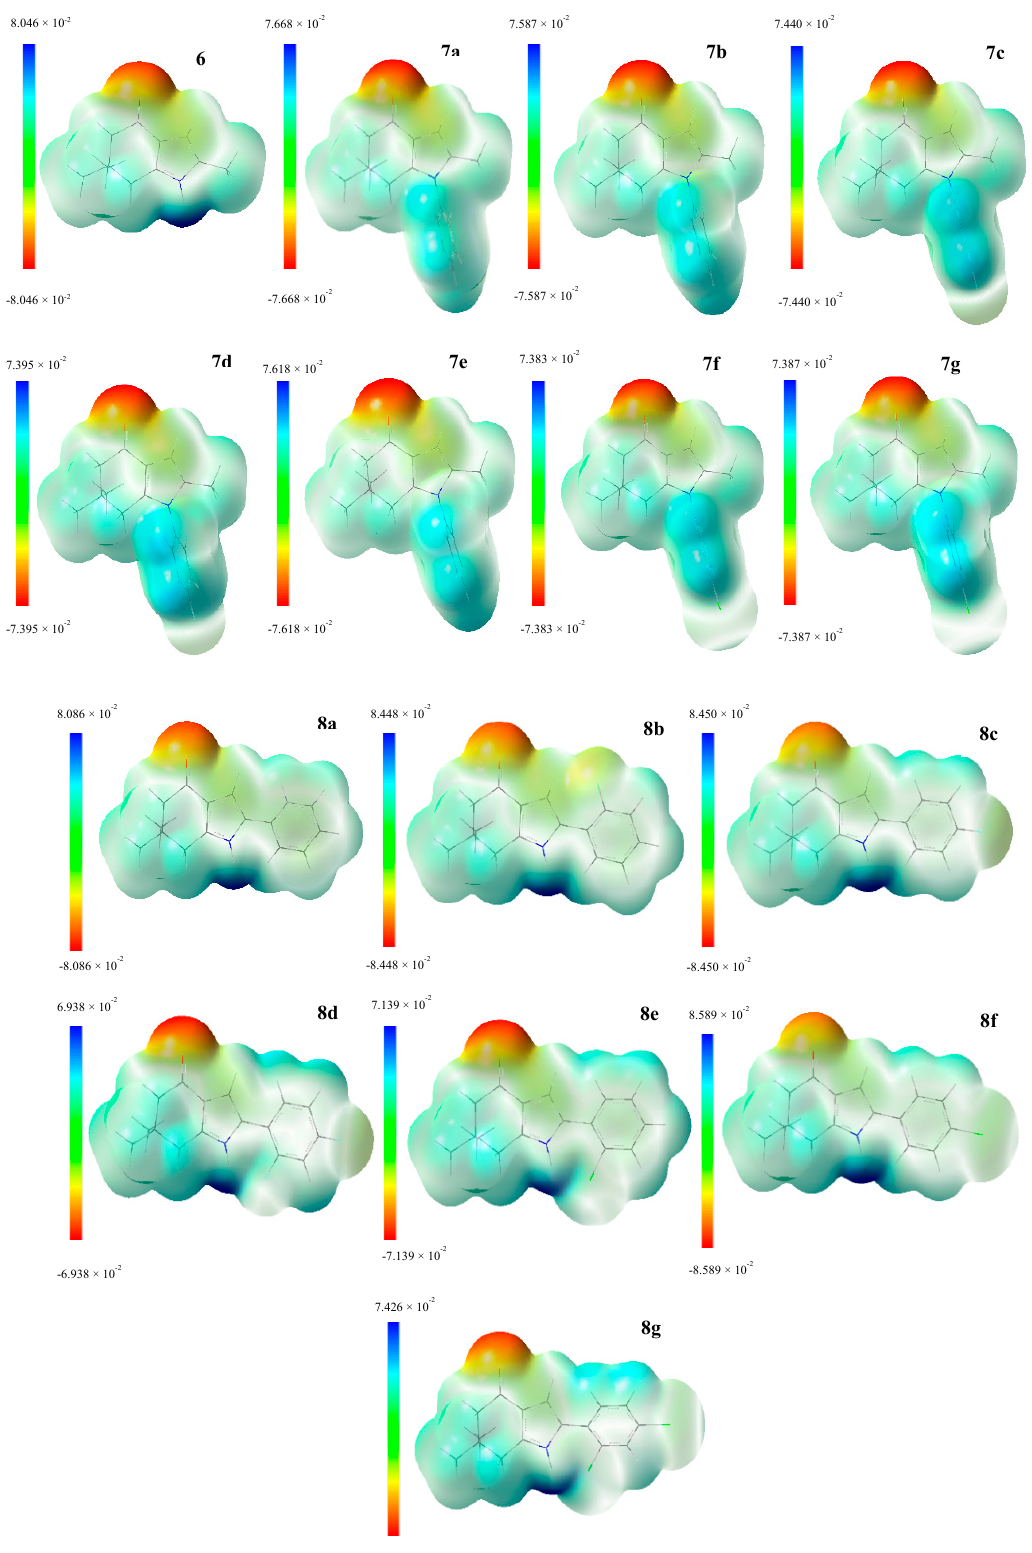
Figure 4. Molecular electrostatic potential maps from series I ( 6 , 7a – g ) and II ( 8a – g ). This chart shows regions with negative values (red), and positive values (blue). The color code is different range depending of the structure; units are given in a.u. for each scale.